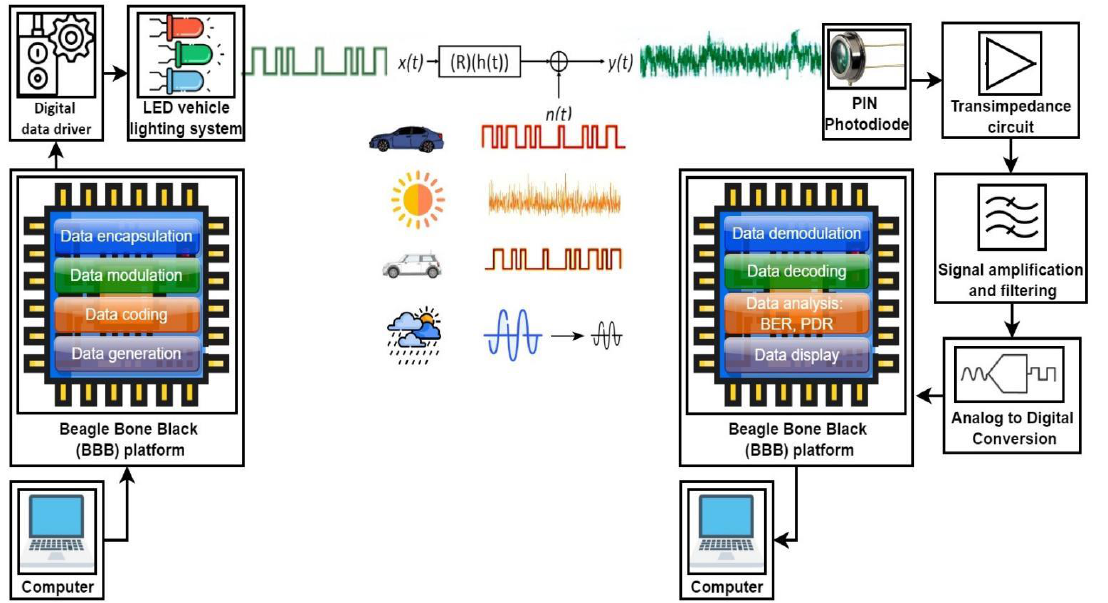
Figure 9. Schematic of the vehicular VLC prototype used in the experimental evaluation process.